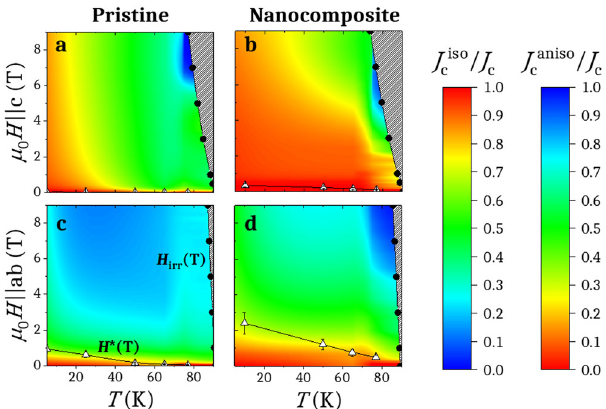
Fig. 3 J c iso / J c and J c aniso / J c in the H – T diagram. μ 0 H – T colour map of the ratios J c iso / J c and J c aniso / J c for ( a , c ) a pristine and ( b , d ) a nanocomposite for ( a , b ) H | | c and ( c , d ) H | | ab. Solid lines with circles and triangles mark the μ 0 H irr ( T ) and μ 0 H *( T ) curves, respectively. Error bars are determined by the standard deviation of μ 0 H * for iterative